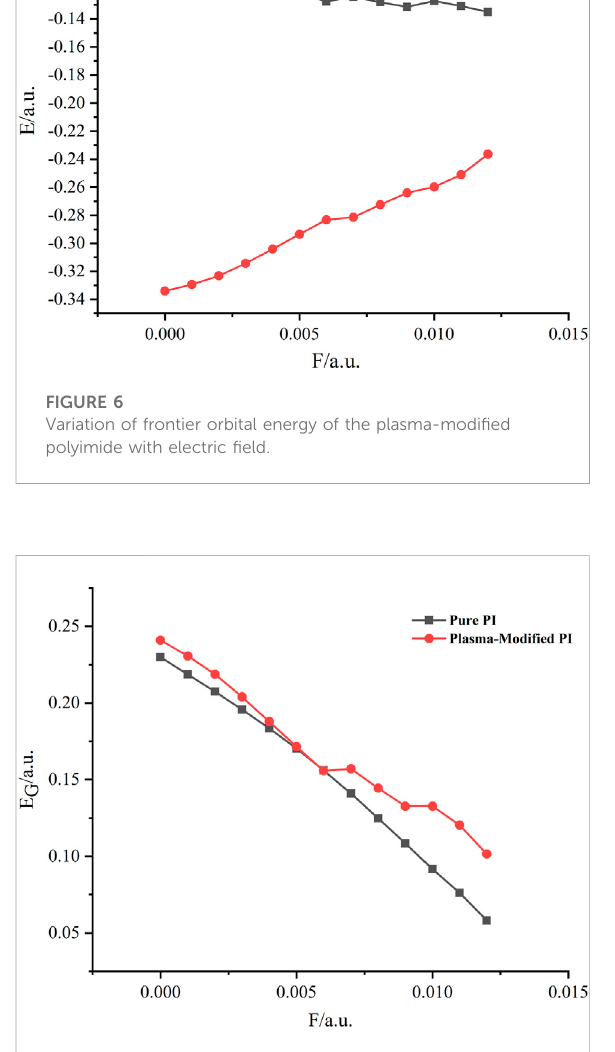
FIGURE 7 Variation of the energy gap with electric fi eld.